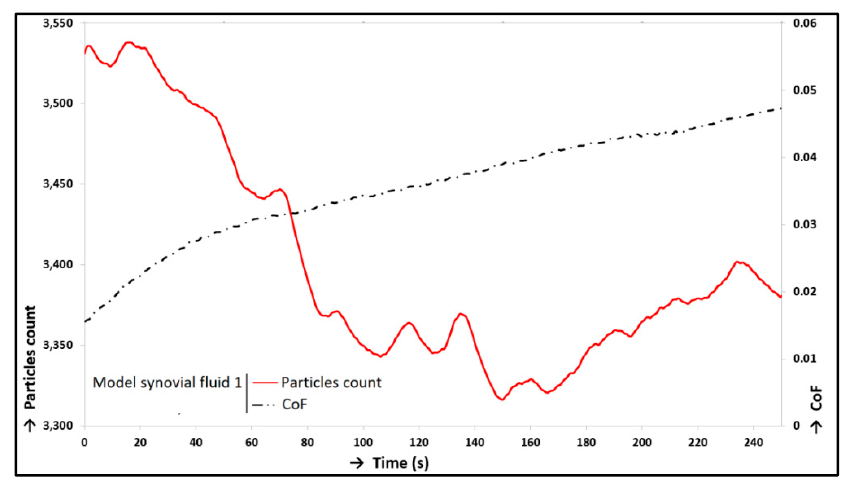
Figure 15. Particle count/average size/time-dependence: Model Synovial Fluids 1 and 2.